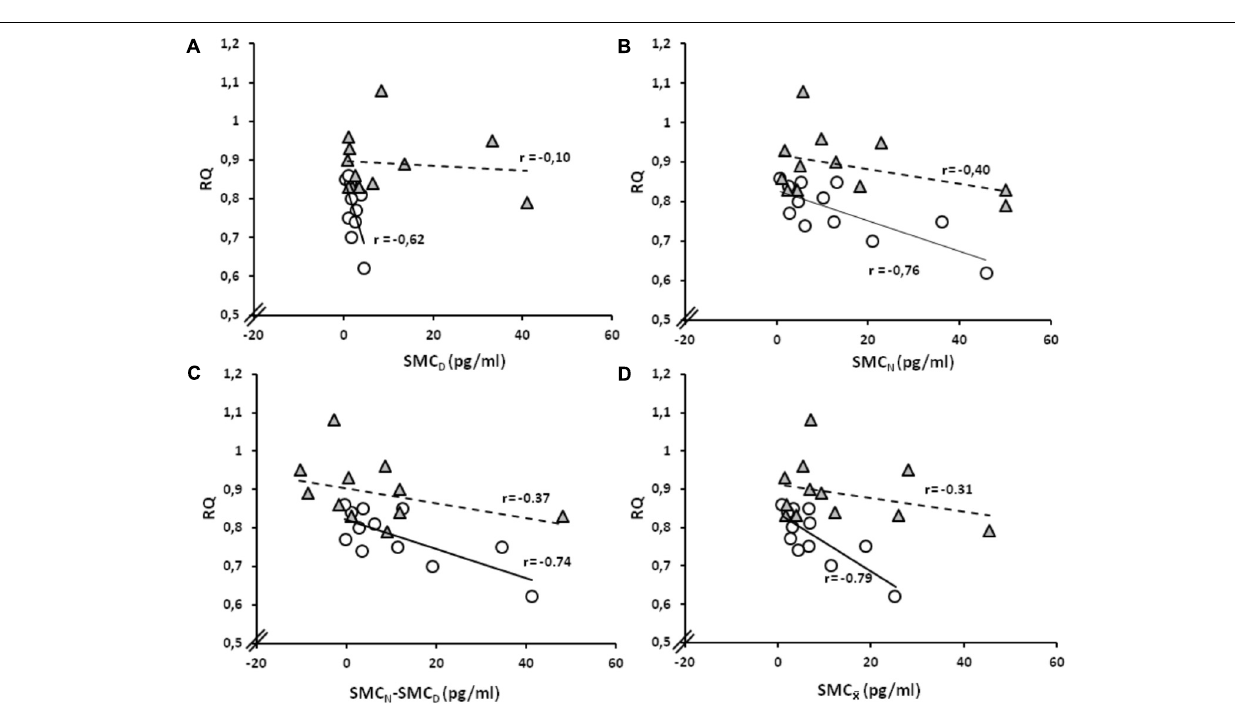
FIGURE 3 | SMC values as related to RQ. (A) Simple linear regression of the relation between RQ and SMC D at SL and HA. (B) Simple linear regression of the relation between RQ and SMC N at SL and HA. (C) Simple linear regression of the relation between RQ and SMC N –SMC D at SL and at HA. (D) Simple linear regression between RQ and SMC ¯ x at SL and HA. White circles and gray triangles, respectively, represent SL and HA values ( n =